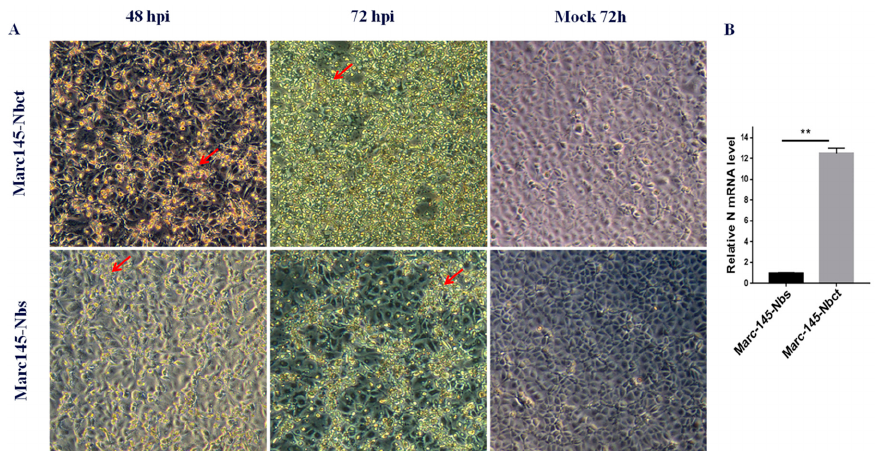
Figure 2. Selection of PRRSV-resistant Marc-145–Nbs. Marc-145–Nbs and Marc-145–Nbct cells were inoculated at 10 MOI of PRRSV JK100 strain. Cells were observed for cytopathic effect (CPE, indicated by red arrows) at 48 and 72 hpi, and mock-infected Marc-145–Nbs and Marc-145–Nbct cells were used as a control (magnification, 100×) ( A ). Cells were collected at 72 h post infection and relative PRRSV N mRNA levels were quantified by real-time PCR. Beta actin served as internal reference (**, P < 0.05) ( B ).